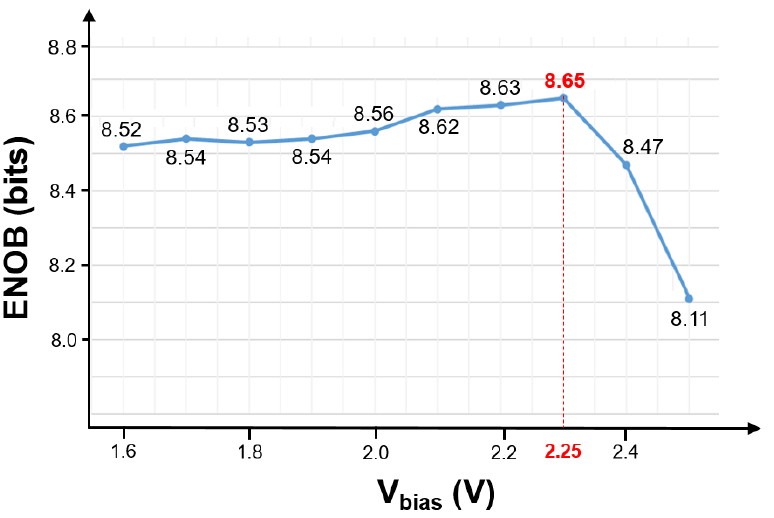
Figure 27. Measured ENOB with respect to bias voltages of 1.6–2.4 V at the input frequency of 200 kHz and sampling frequency of 5.0 MS/s.